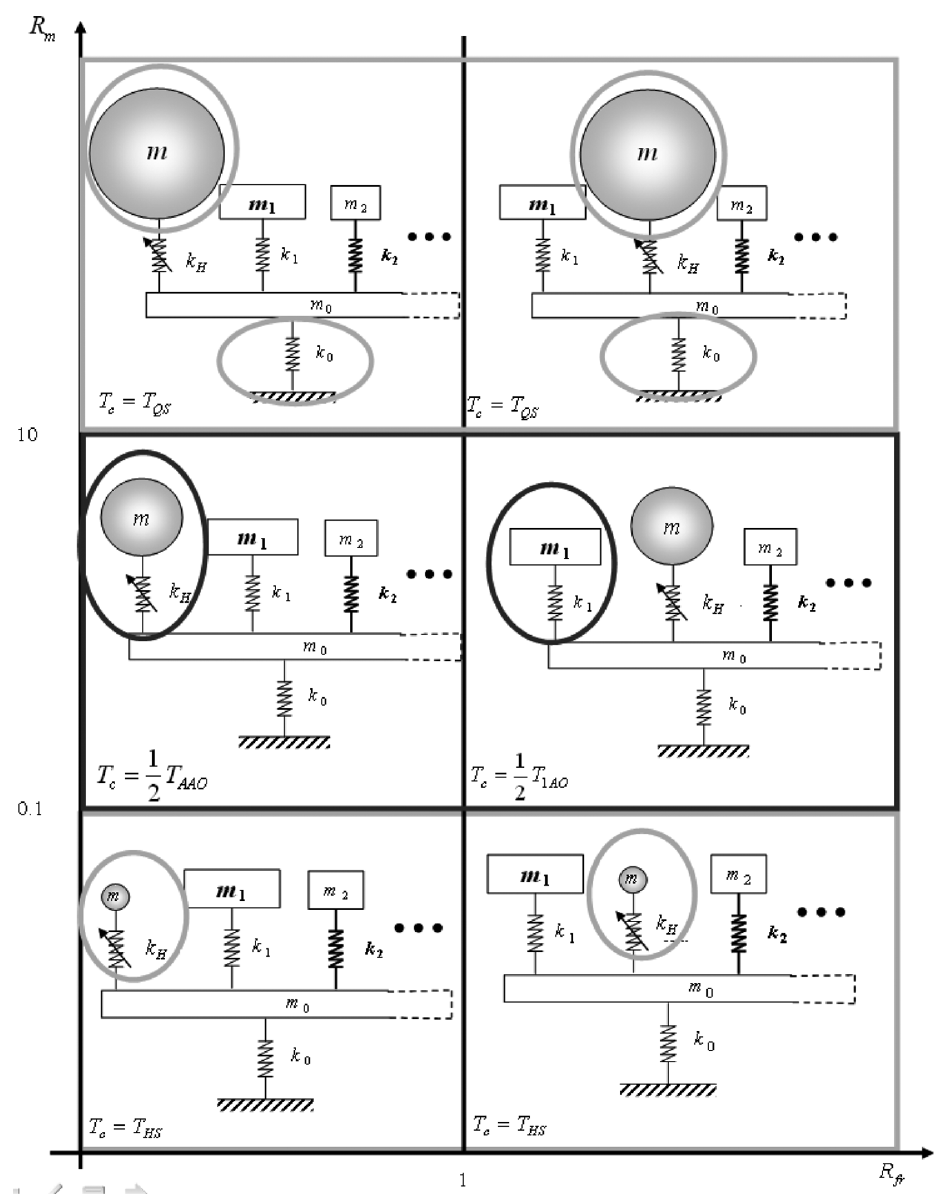
Fig. 5. PP beam/mass Impact duration: